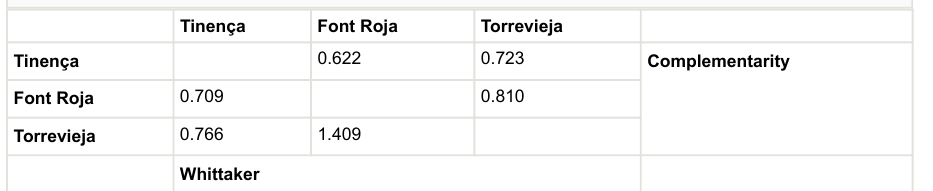
Whittaker index and Complementarity index values for Aspilota -group between Natural Parks.